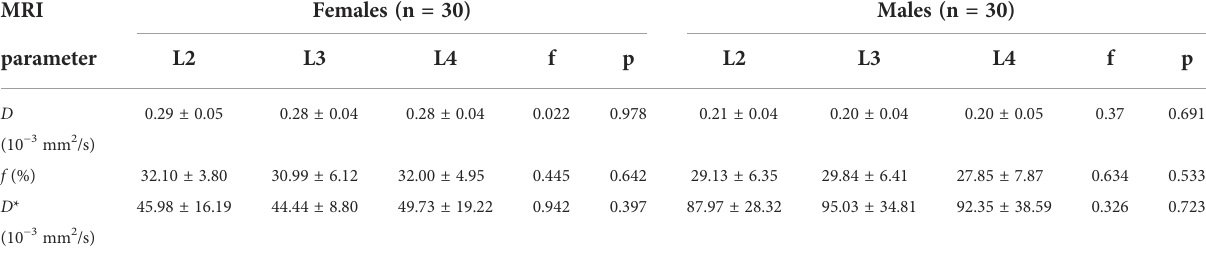
TABLE 2 MRI parameter of women and men in different vertebral